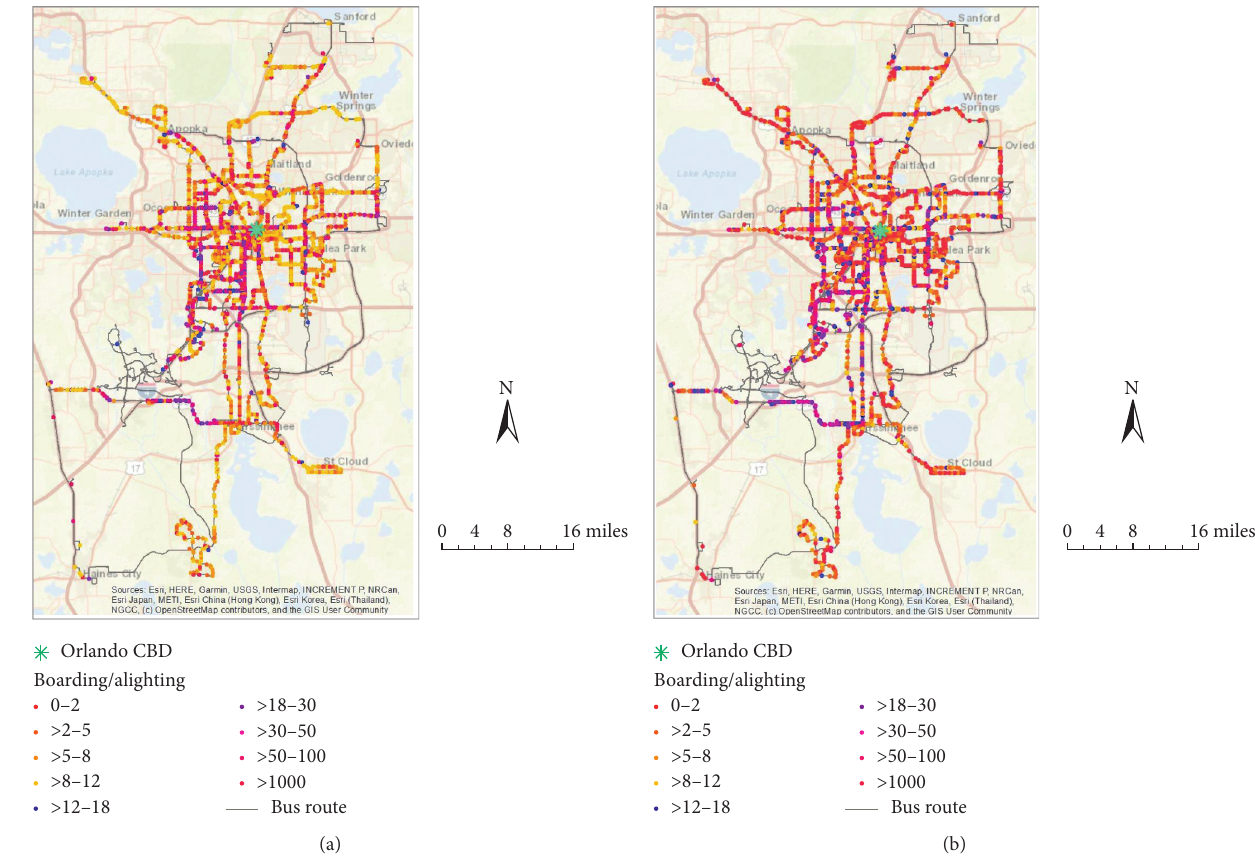
Figure 2: Public transit Ridership for April-15 quarter. (a) Boarding and (b) alighting.